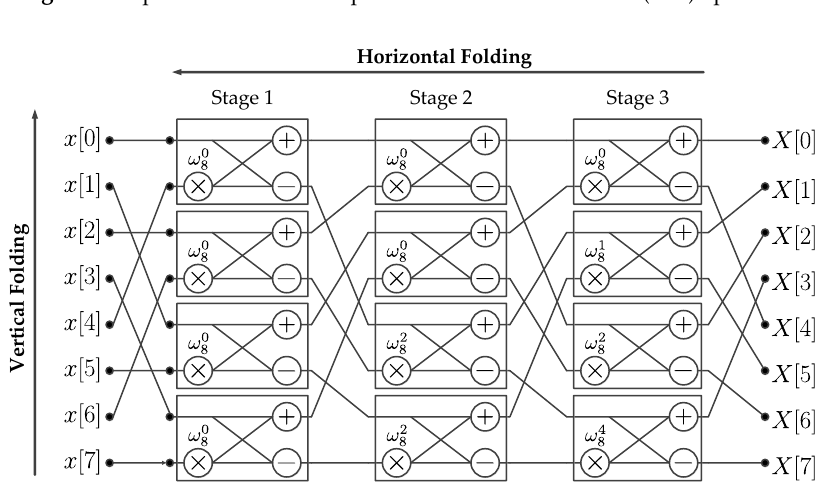
Figure 2. 8-point Pease FFT